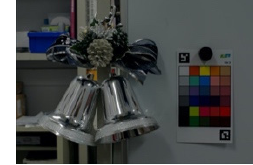
Figure 3. Generated high dynamic range image.